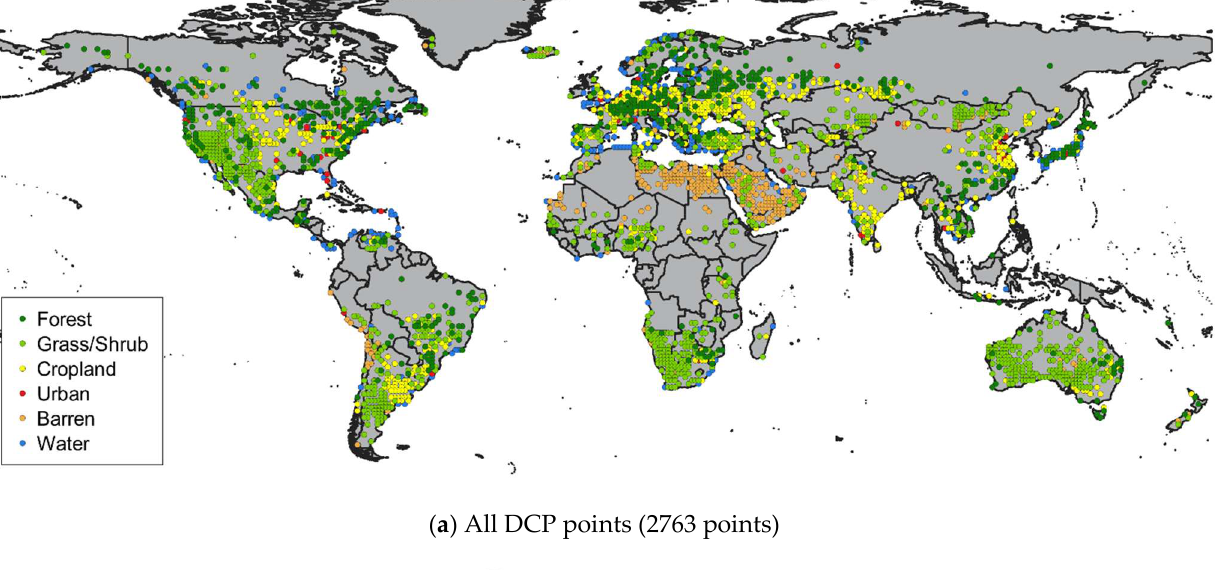
Figure 3. The proportion of DCP points with guaranteed spatial uniformity among all DCP points in each class.